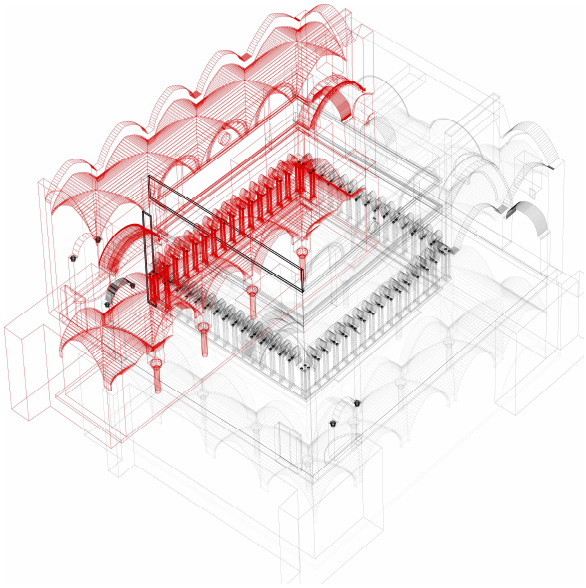
Figure 8. The digital model of the virtual